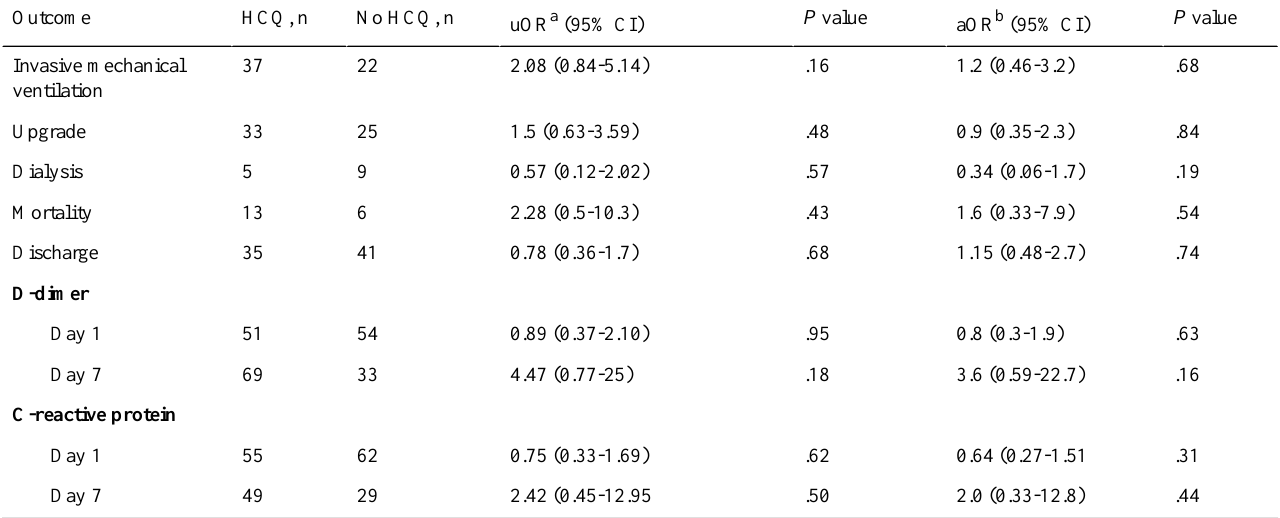
Table 3. Hydroxychloroquine (HCQ) regression analysis with